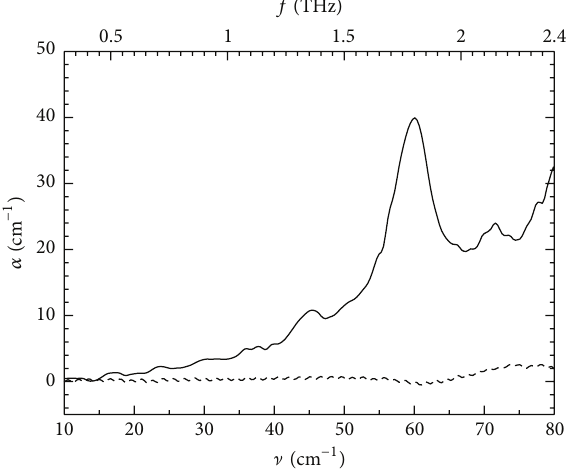
Figure 4: Measured FTIR absorbance ( dashed blue line ) and effective absorbance data after removal of the etalon effects from THz-TDS measurement ( red solid line